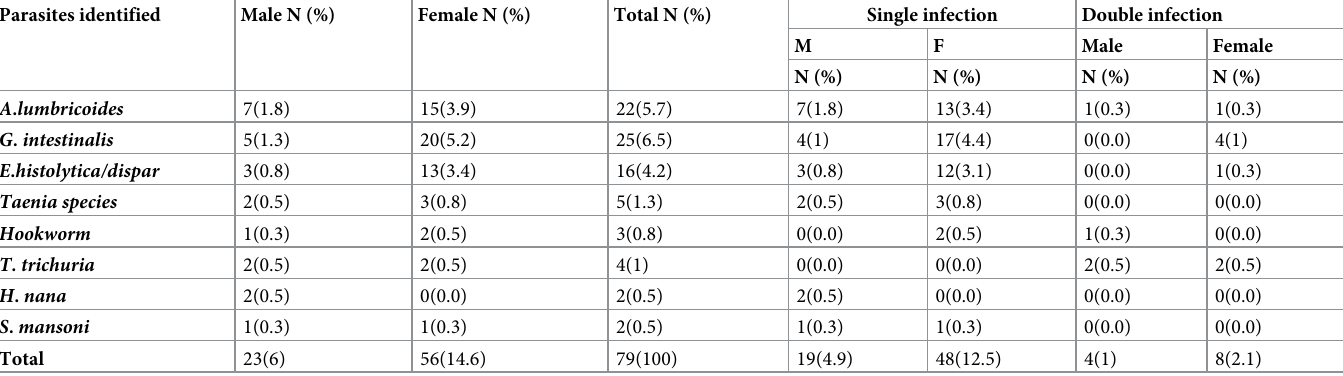
Table 3. Distribution of intestinal parasite prevalence and types of infections among patients requested for stool examination, Jimma health center, Southwest, Ethiopia (n = 384). Parasites